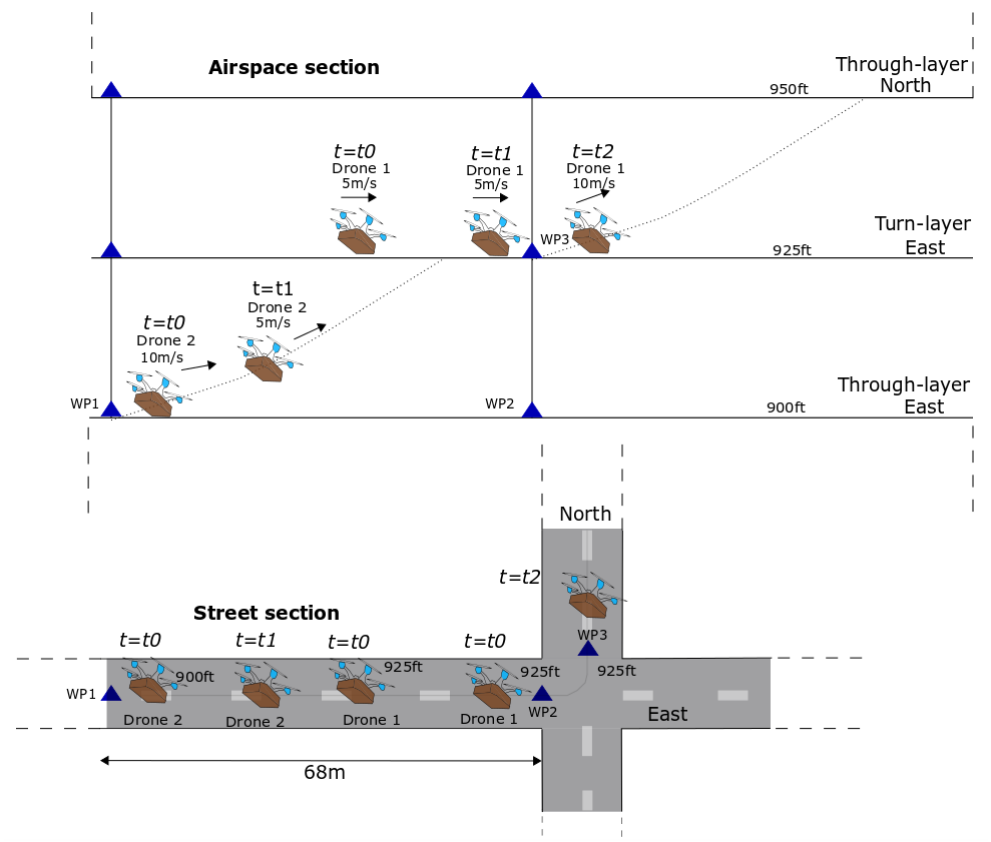
Figure 11. Graphical explanation on a typical short-distance street that shows the merge assistance policies to be less effective because of the inability of the merge assistance policies to fully respond and resolve any merging